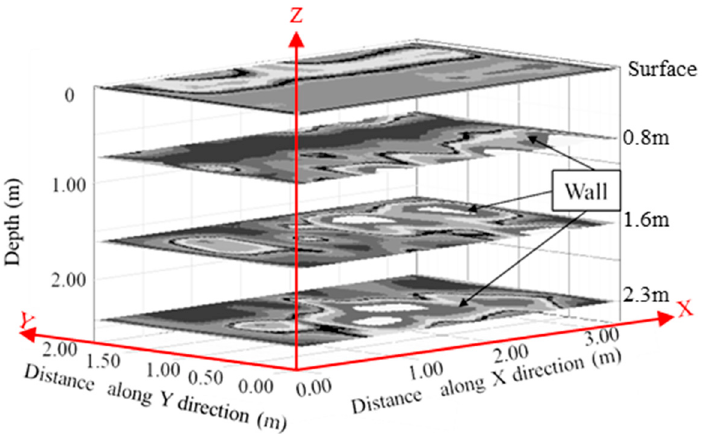
Figure 18. Depth slices with different depths (0, 0.8, 1.6, 2.3 m) were generated from a 3D plot at Qaser